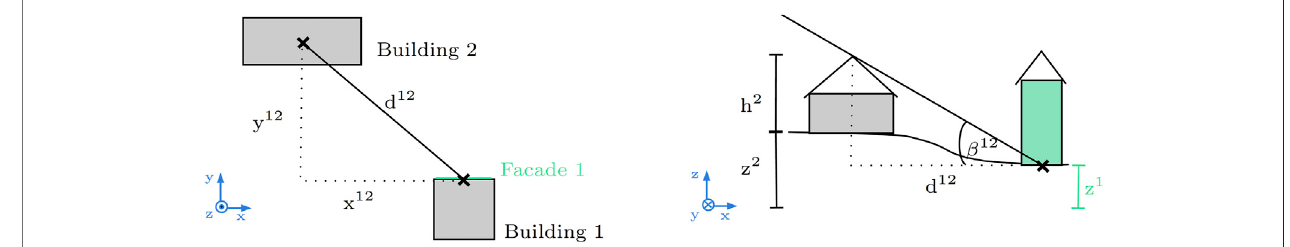
FIGURE 2 | Exemplary visualization of the geometry for facade 1, with distance d 12 to building two and the sky limiting angle β .